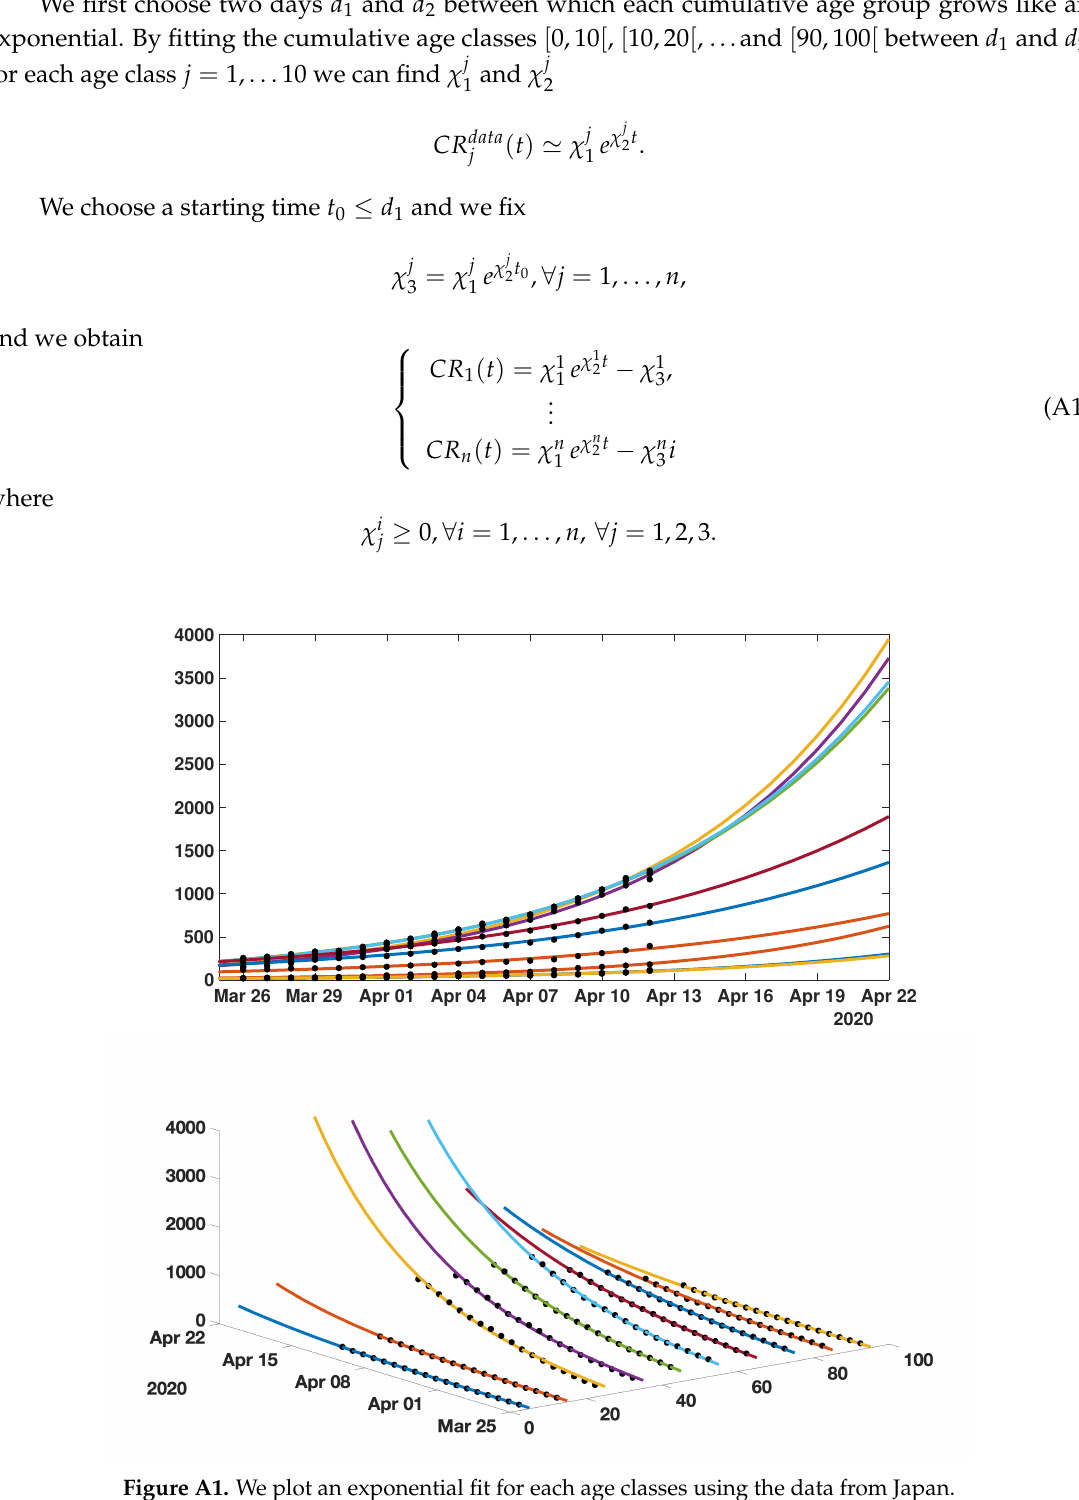
Figure A1. We plot an exponential fit for each age classes using the data from